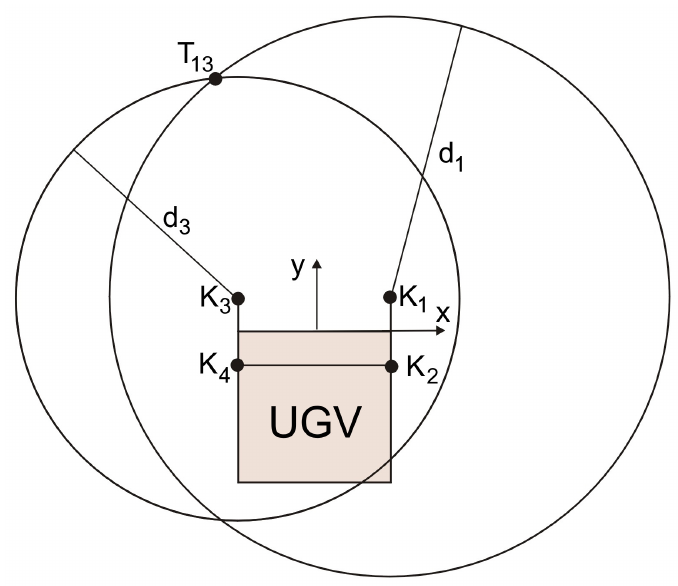
Figure 8. Determining the location of the guide with the use of anchors no. 1 and no. 3.